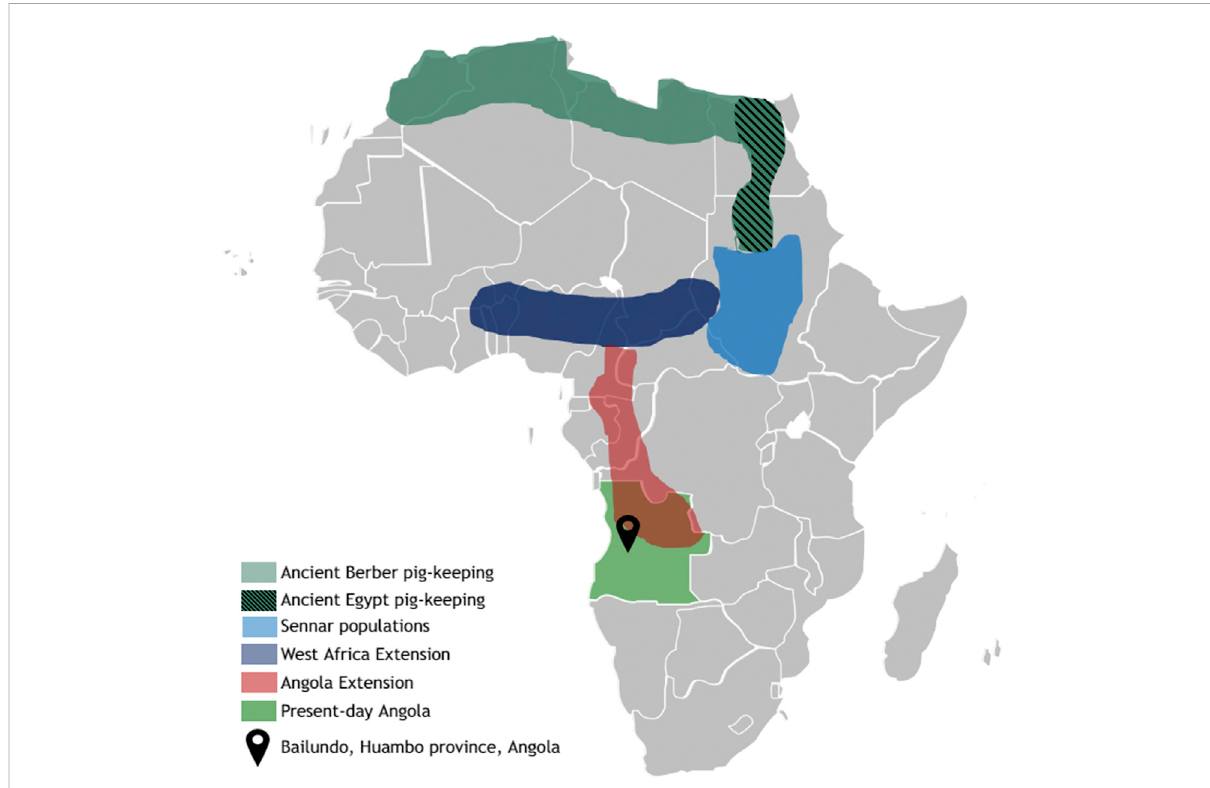
FIGURE 1 Historical distributionofpig-keeping inAfrica. Pig domesticationwasavery important practice fornorthAfricancultures (Berberand Egyptian), until the practice was eliminated with the spread of the Islamic culture. Despite this bottleneck in northern territories, reports exist describing domestication centers that kept existing in central Africa (Sennar region and the West Africa Extension), reaching the Angola extension — a strip stretching territory from the south of Cameroon, through Congo and down into Angola. Adapted from Blench, 2000